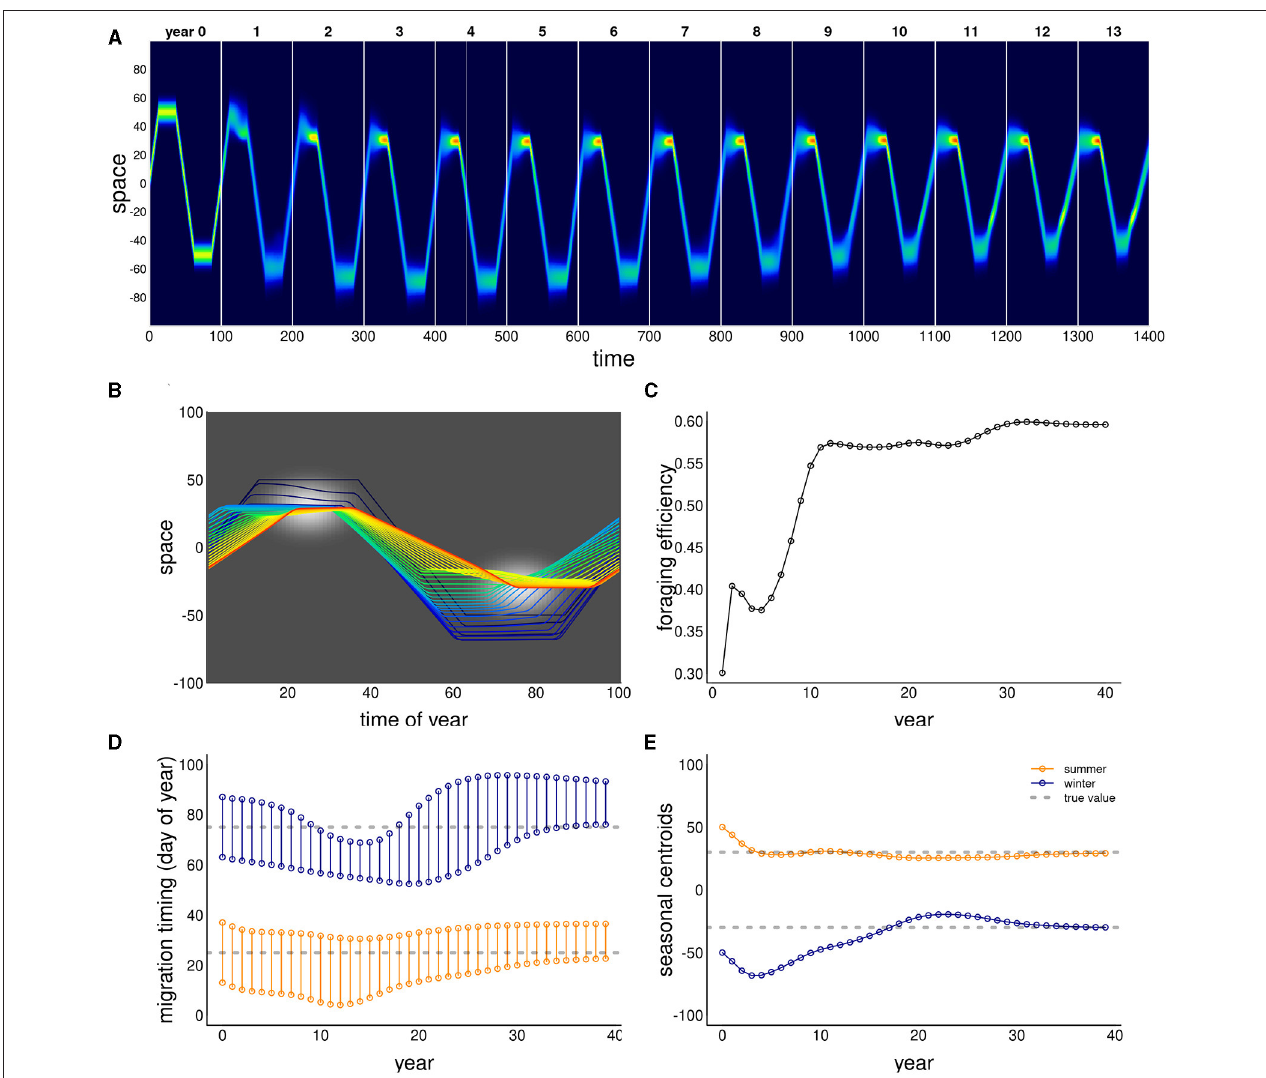
FIGURE 2 | Example of adaptation to a shift in resource peak. The initial (year 0) behavior migrates to locations 50 and –50 at days 15 and 60, whereas the resource peak is at 30 and –30, peaking at times 25 and 75. The panels show (A) the first 14 years of the simulation; (B) the centroid of the annual movement of the population is shown in panel b, with dark blue to red colors indicating 0–40 year; (C) annual foraging efficiency across years; (D) migration timing parameters for each year, with orange segments indicating arrival and departure from the summering (northern) grounds, and the blue segments indicating timing of arrival and departure at the wintering grounds; (E) migration arrival and departure location across years, with blue and orange indicating winter (southern) and summer (northern)